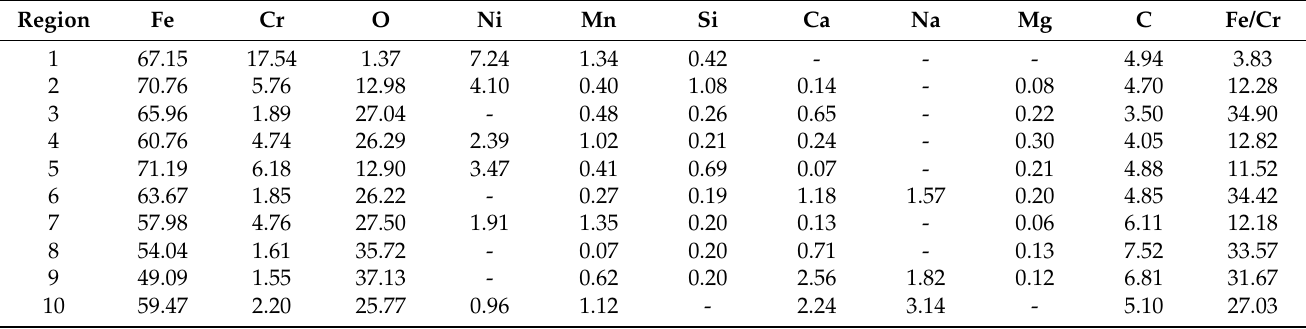
Table 5. EDS elemental analysis of regions marked in Figure 7 for 304SS alloy (in